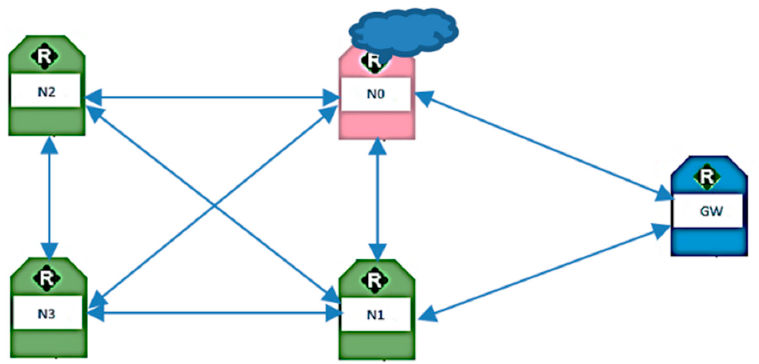
Figure 6. Five Node wireless sensor network (WSN) Test Bed Setup.